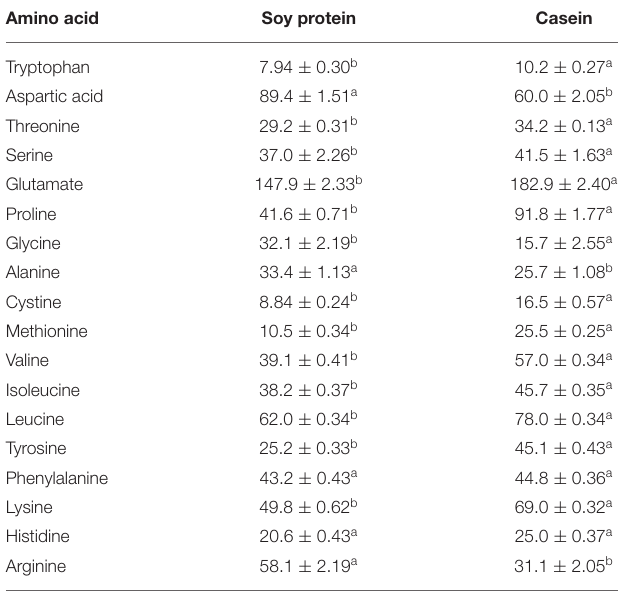
TABLE 2 | Amino acid composition (mg · g − 1